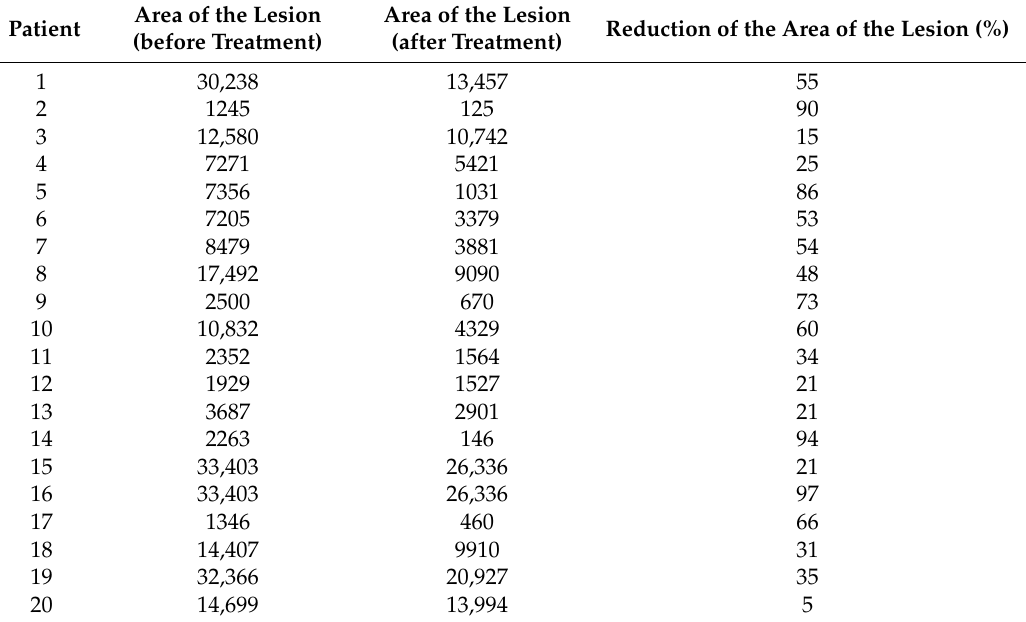
Table 1. Area of the lesion before and after treatment with chitosan (CHI) formulation and the percentage of reduction of the lesion for each patient.